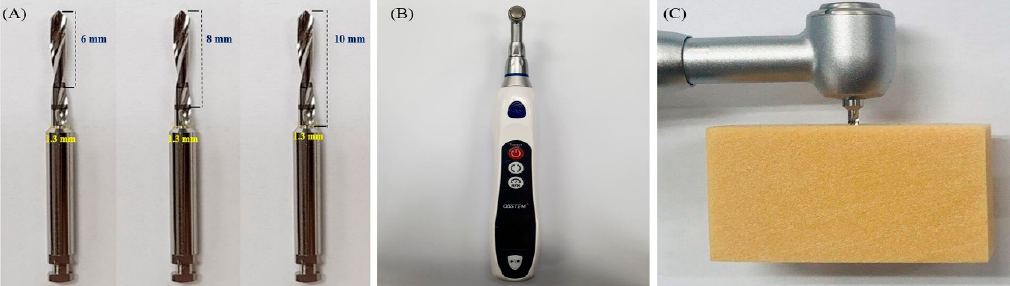
Figure 4. Predrilling of artificial bone. ( A ) orthodontic drills; ( B ) orthodontic automatic device; ( C ) predrilling method.